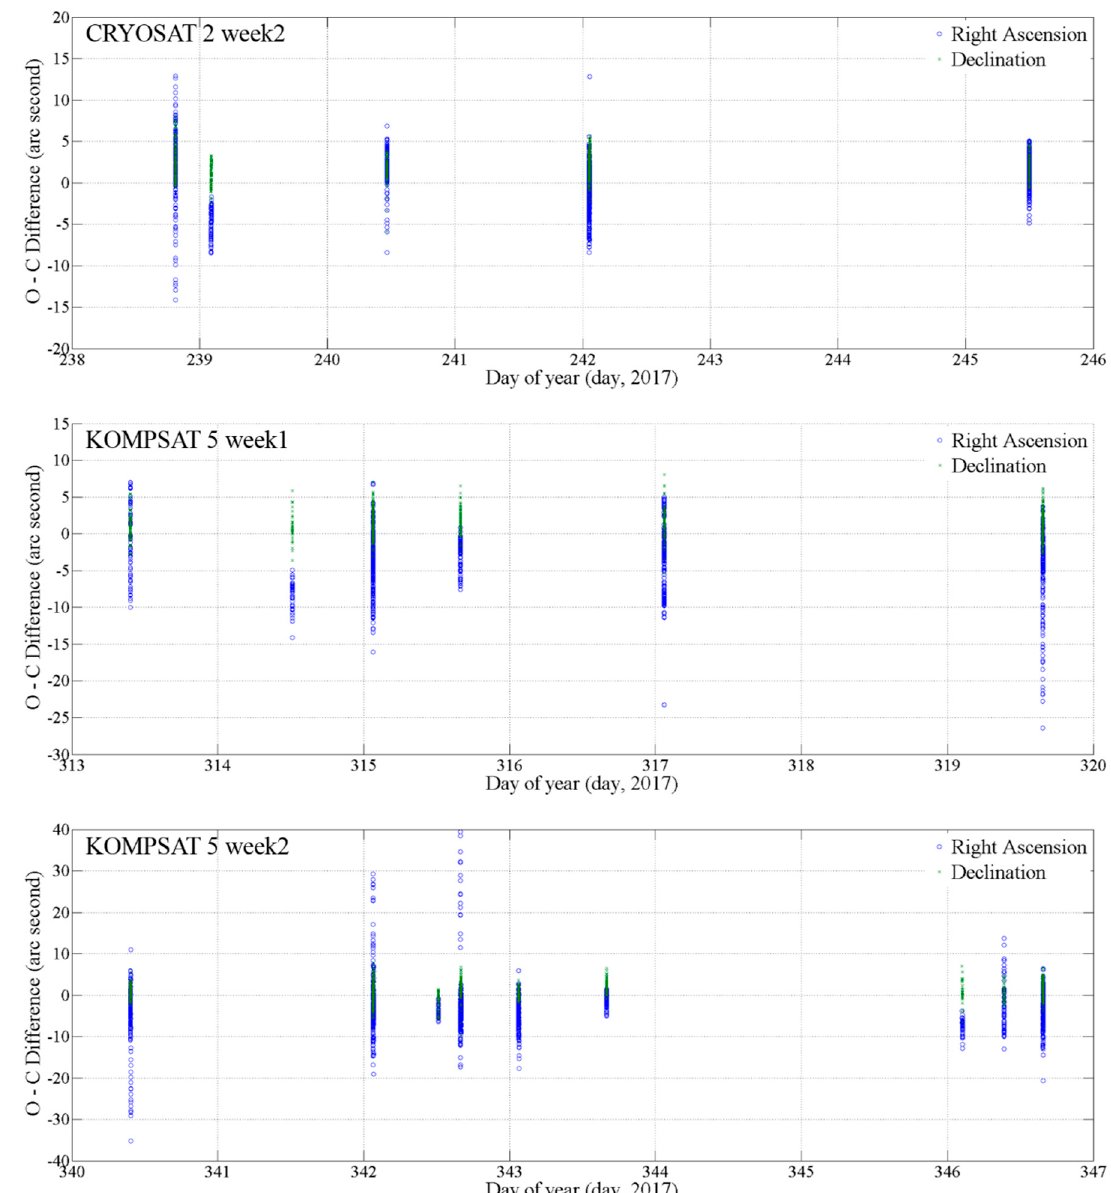
Figure 5. Residual O-C difference between the optical observation data from the OWL-Net and the comparison CPF data for CRYOSAT 2 in August 2017 for the first graph. The second and third graphs show the difference between the optical observation data from the OWL-Net and onboard Global Positioning System (GPS) data. The optical observation data for KOMPSAT 5 was performed in November 2017 and December 2017, respectively. The maximum difference for KOMPSAT 5 was bigger than the result for CRYOSAT 2.